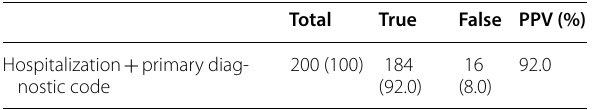
Table 2 Validation of diagnostic codes for myocardial infarction